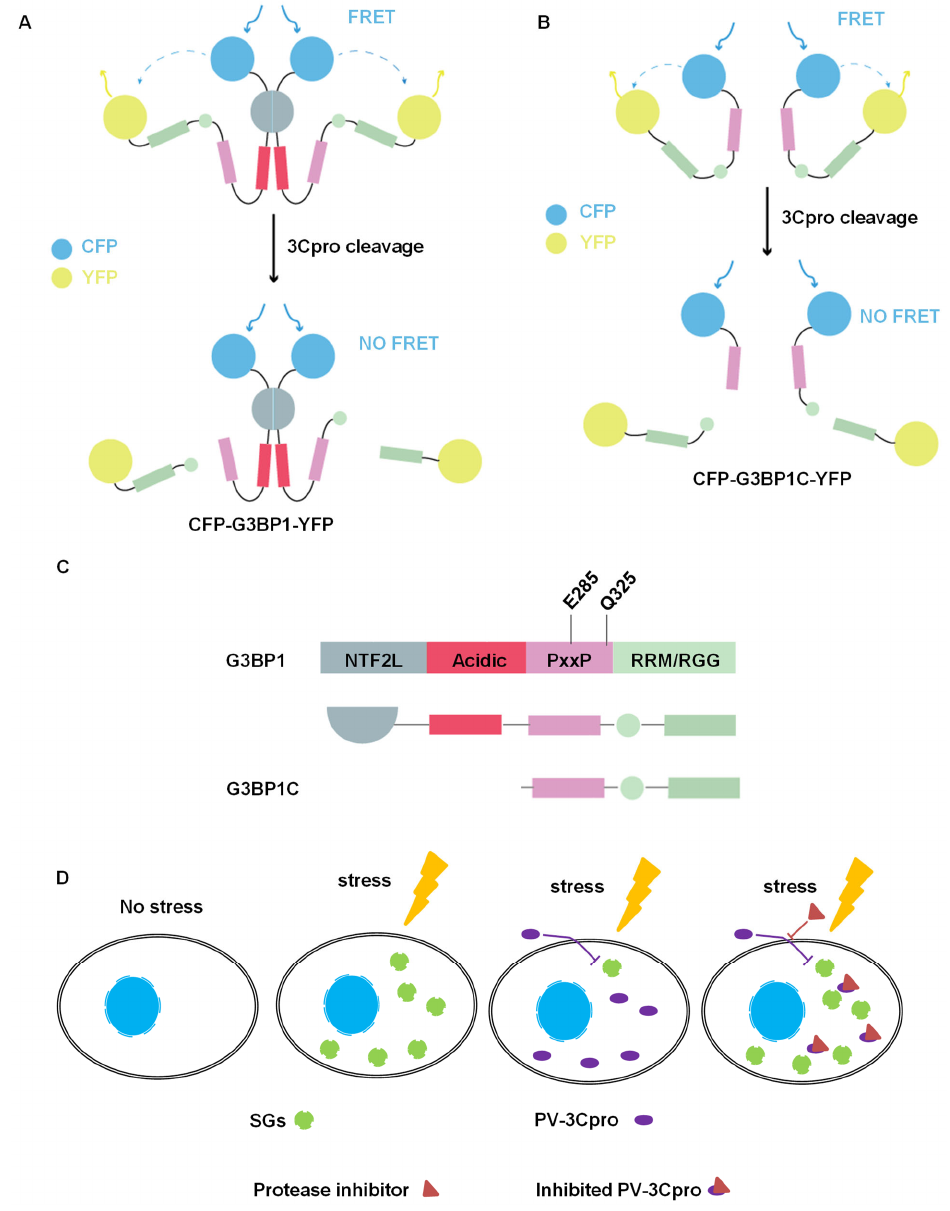
Figure 2. Schematic representation of FRET and SG dual-based system used for screening PV 3Cpro inhibitors. ( A , B ) Schematic graph showing the mechanism of FRET-based screening to monitor cleavage of G3BP1 by 3Cpro. ( C ) The cleavage sites of G3BP1 protein by picornaviral 3Cpro. Both the full-length and its C-terminal fragment were used to generate CFP-G3BP1-YFP and CFP-G3BP1C-YFP as substrates of PV 3Cpro. ( D ) Schematic graph showing the mechanism of SG-based screening to monitor SG